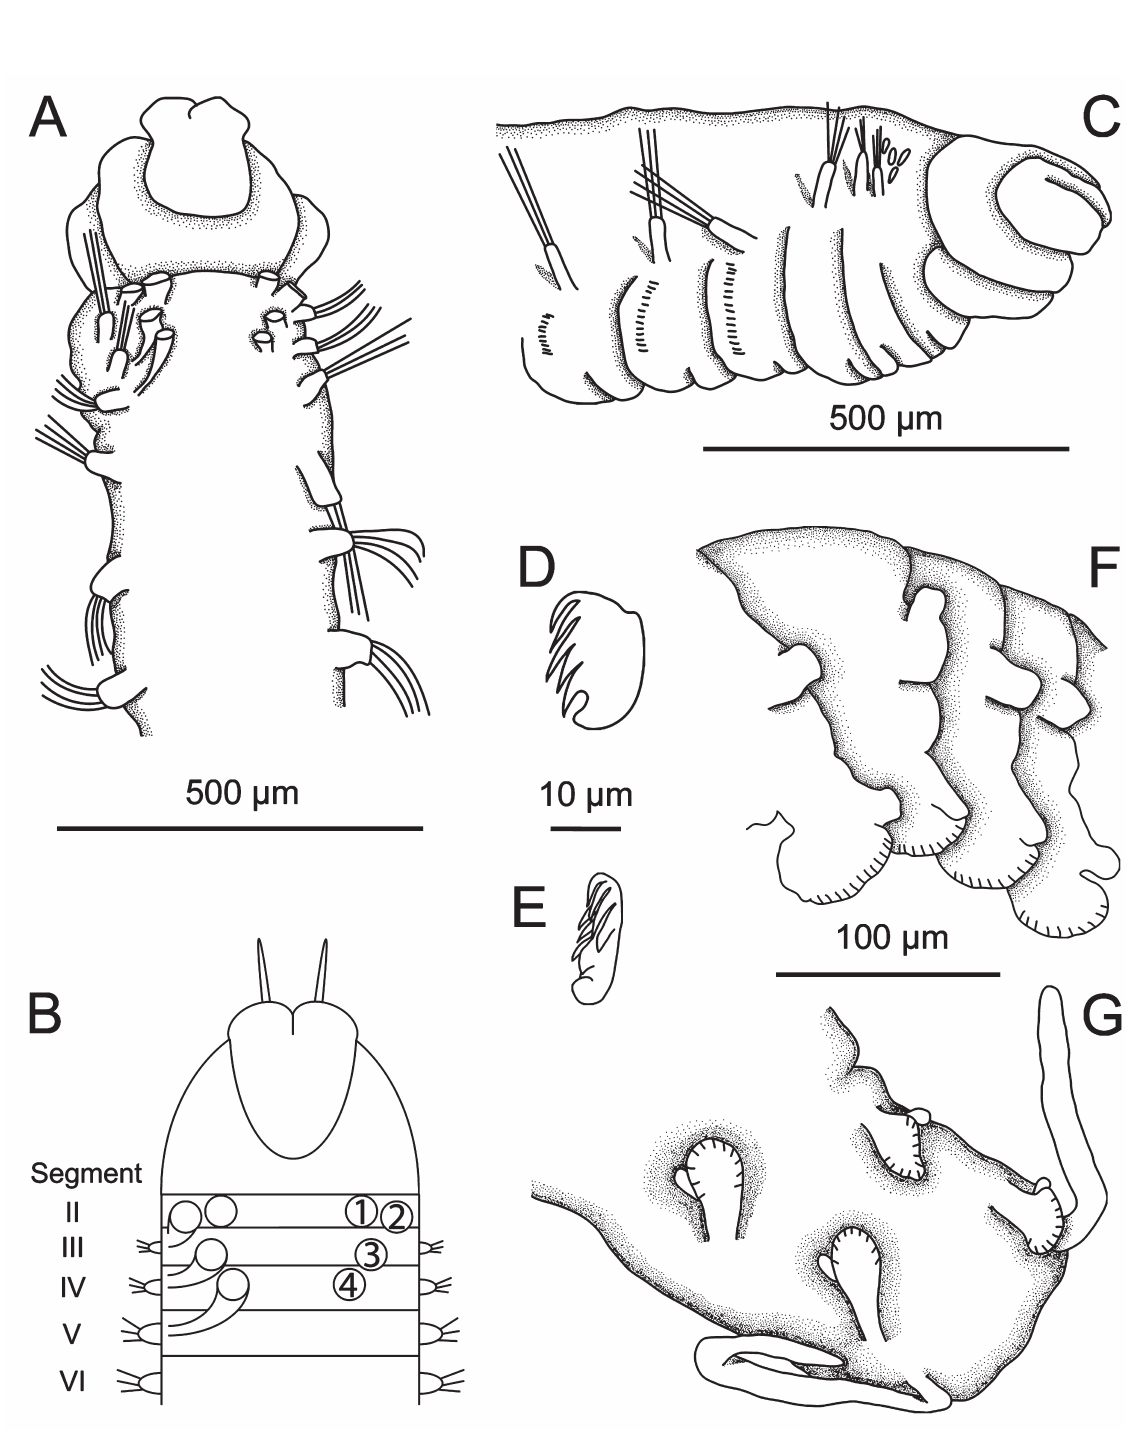
Fig. 1. Amage imajimai sp. nov. A . Anterior end of holotype, dorsal view. B . “ID card”. C . Anterior end of holotype, lateral view. D . Thoracic uncinus, lateral view. E . Thoracic uncinus, frontal view. F . Abdominal uncinigers, lateral view (from paratype sMF 24086). G . Posteriormost abdominal uncinigers and pygidium, ventral view (from paratype sMF